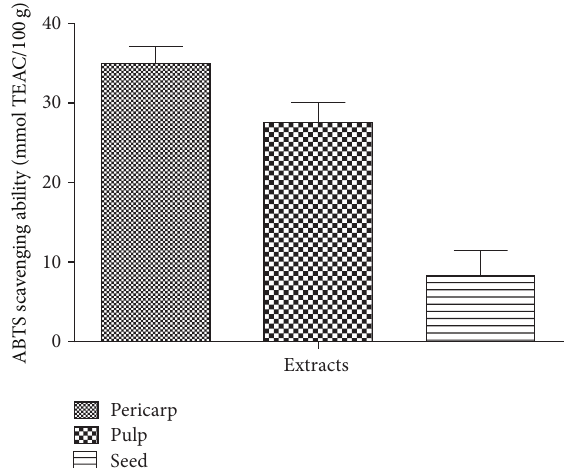
Figure 5: ABTS radical scavenging ability of the aqueous extracts of the pericarp, pulp, and seed of Soursop fruit.